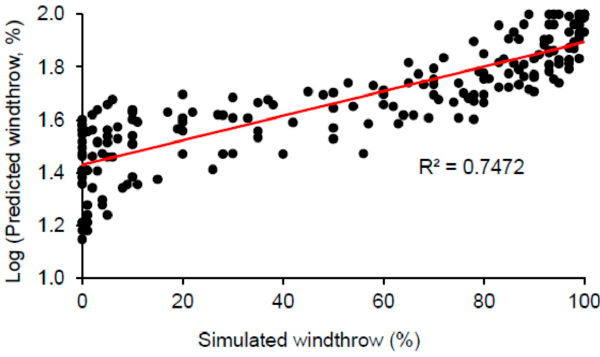
Figure 5. Scatter graph showing the fit between the simulated and predicted percent windthrow estimates. Table 3. Variability in windthrow explained by wind speed, stand height class, and stand type.